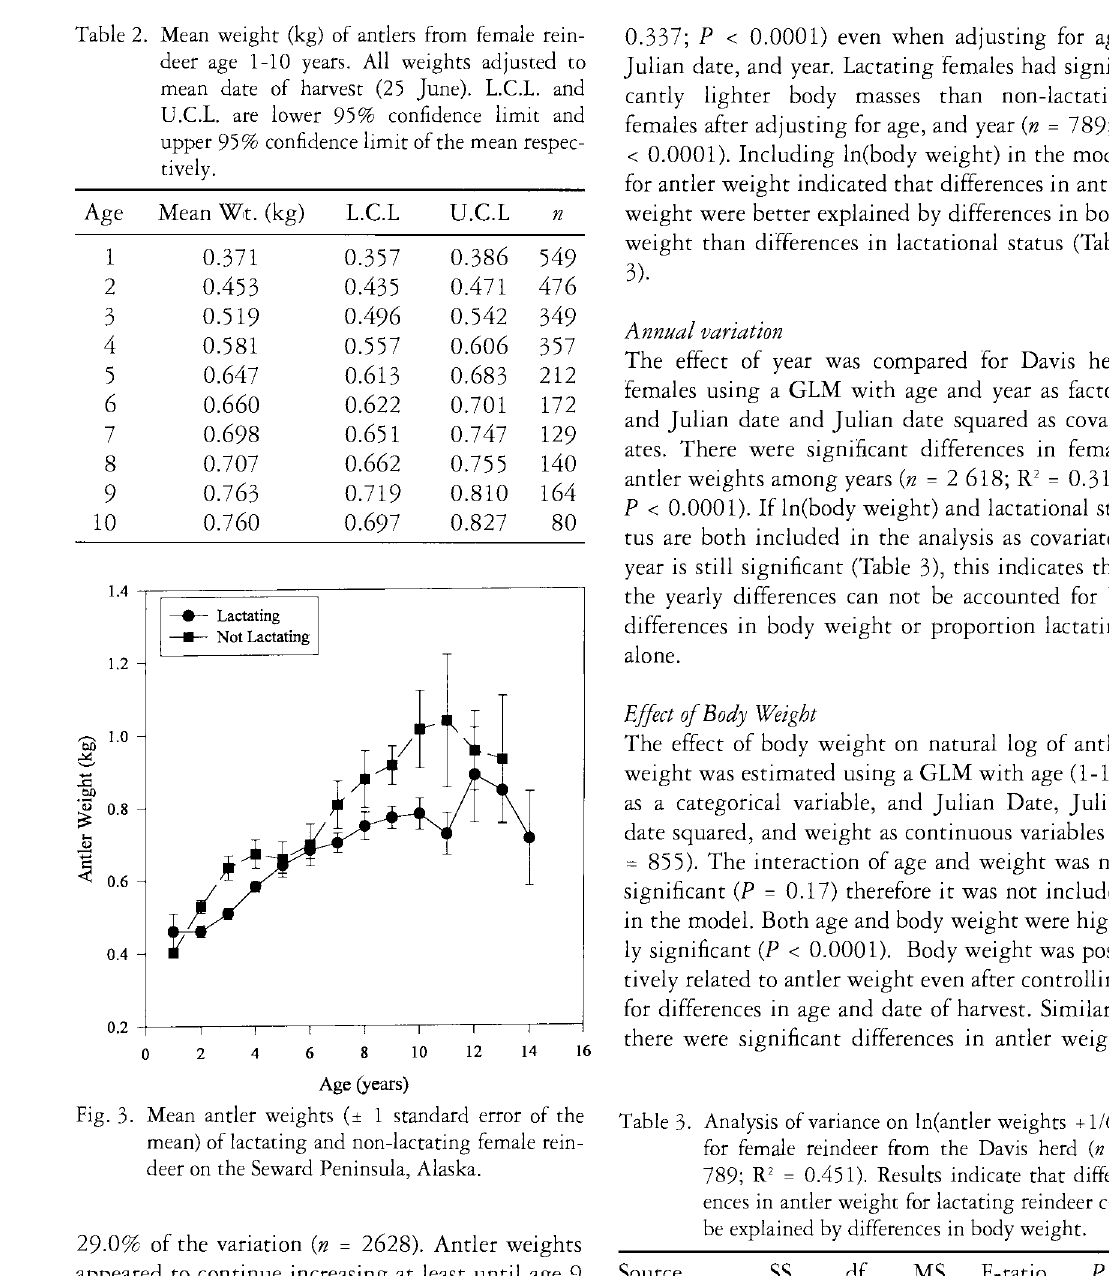
Table 3. Analysis of variance on ln(antler weights +1/6), for female reindeer from the Davis herd (n = 789; R 2 = 0.451). Results indicate that